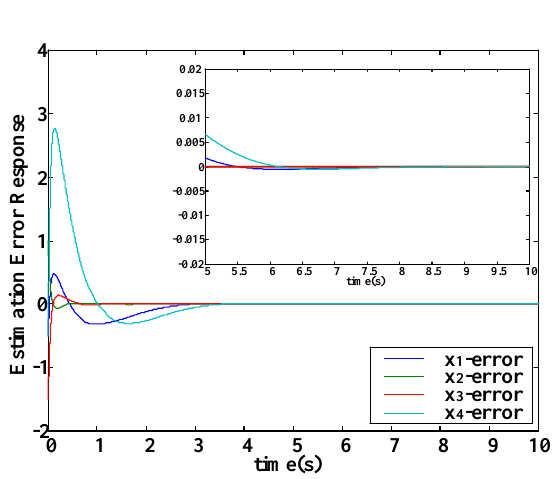
Figure 6. Estimation error responses by PIO.